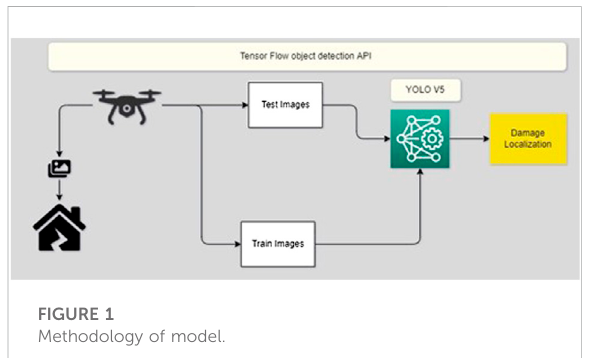
FIGURE 1 Methodology of model.